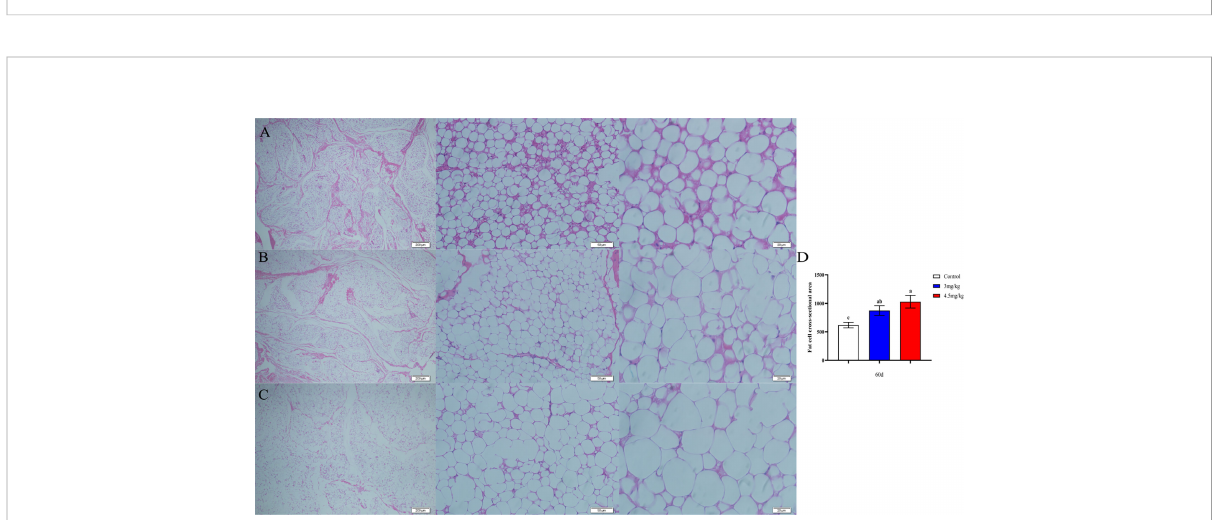
FIGURE 6 Cross-sectional cytogram of dorsal adipose tissue. (A) Transverse sections of the back adipose tissue in the control group, 200×, 50×, and 20×, respectively; (B) Transverse sections of the back adipose tissue in the 3mg/kg group, 200×, 50×, and 20×, respectively; (C) The cross section of the back adipose tissue in the 4.5mg/kg group, 200×, 50×, and 20×, respectively; (D) Statistical analysis of the cross-sectional area of dorsal adipose tissue. Different lowercase letters indicate P <0.05 vs